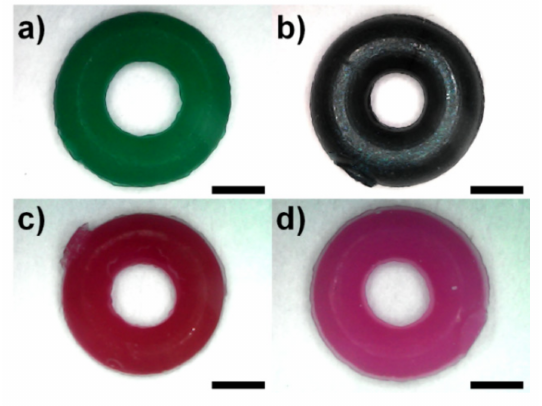
Figure 1. Representative top-view images of the commercial orthodontic elastic ligature ties used in this study: ( a ) Brand A (Dentsply Sirona); ( b ) Brand B (Dent-Mate); ( c ) Brand C (DynaFlex ® ); and ( d ) Brand D (Skyortho Dental Supplies Medical). Scale bar = 1 mm. Table 1. Details of the commercial mouthwashes used in this study. Ingredients Listed on the